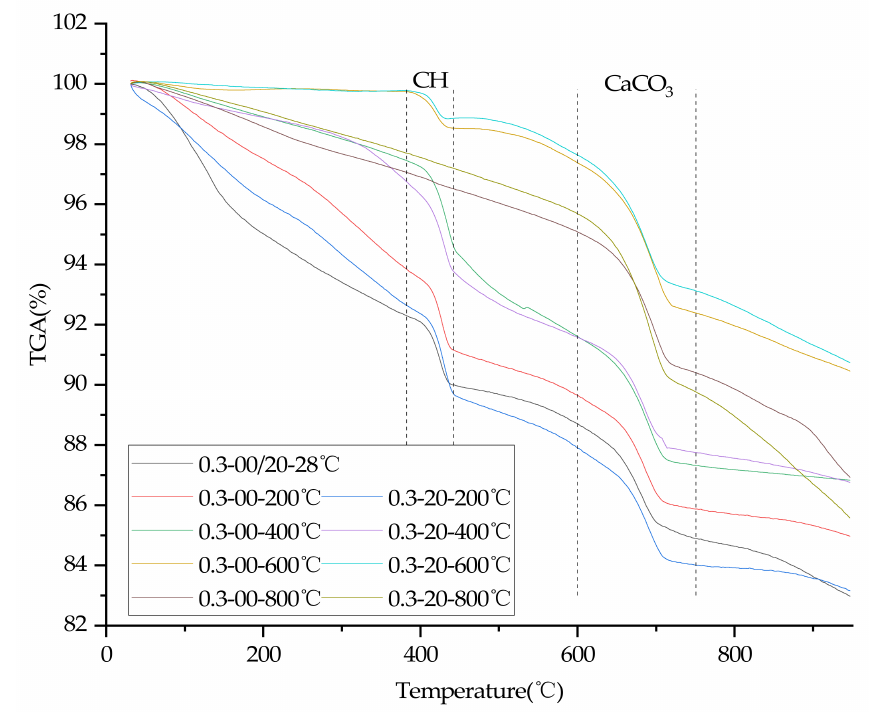
Figure 8. TGA test results of concrete specimens (water/cement ratio of 0.30).